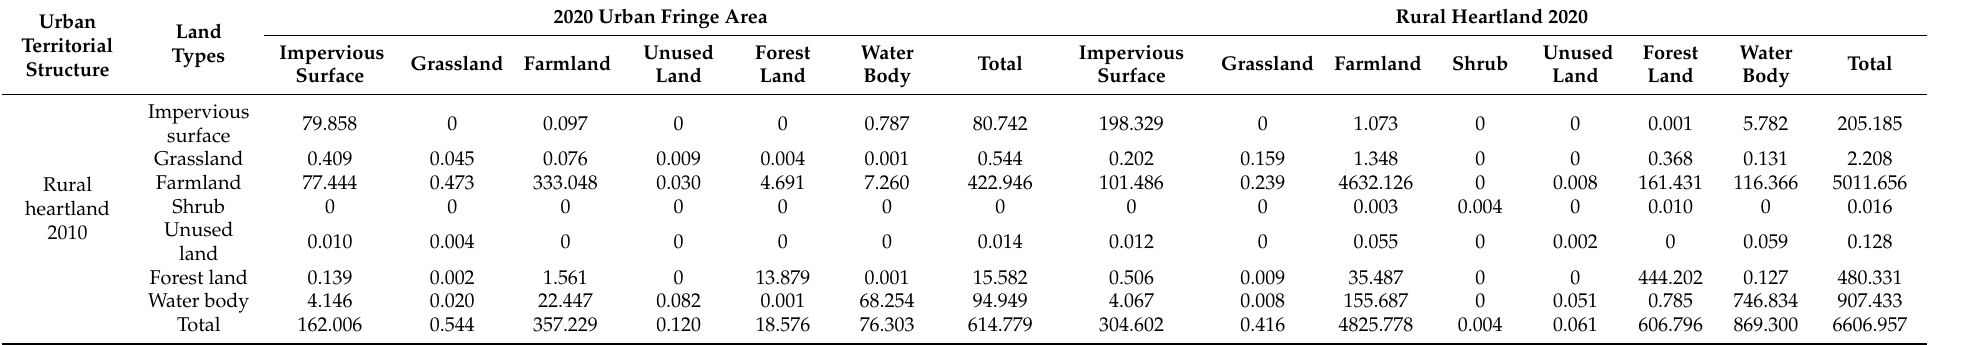
Table A4. Wuhan Land Use Transfer Matrix of rural heartland,